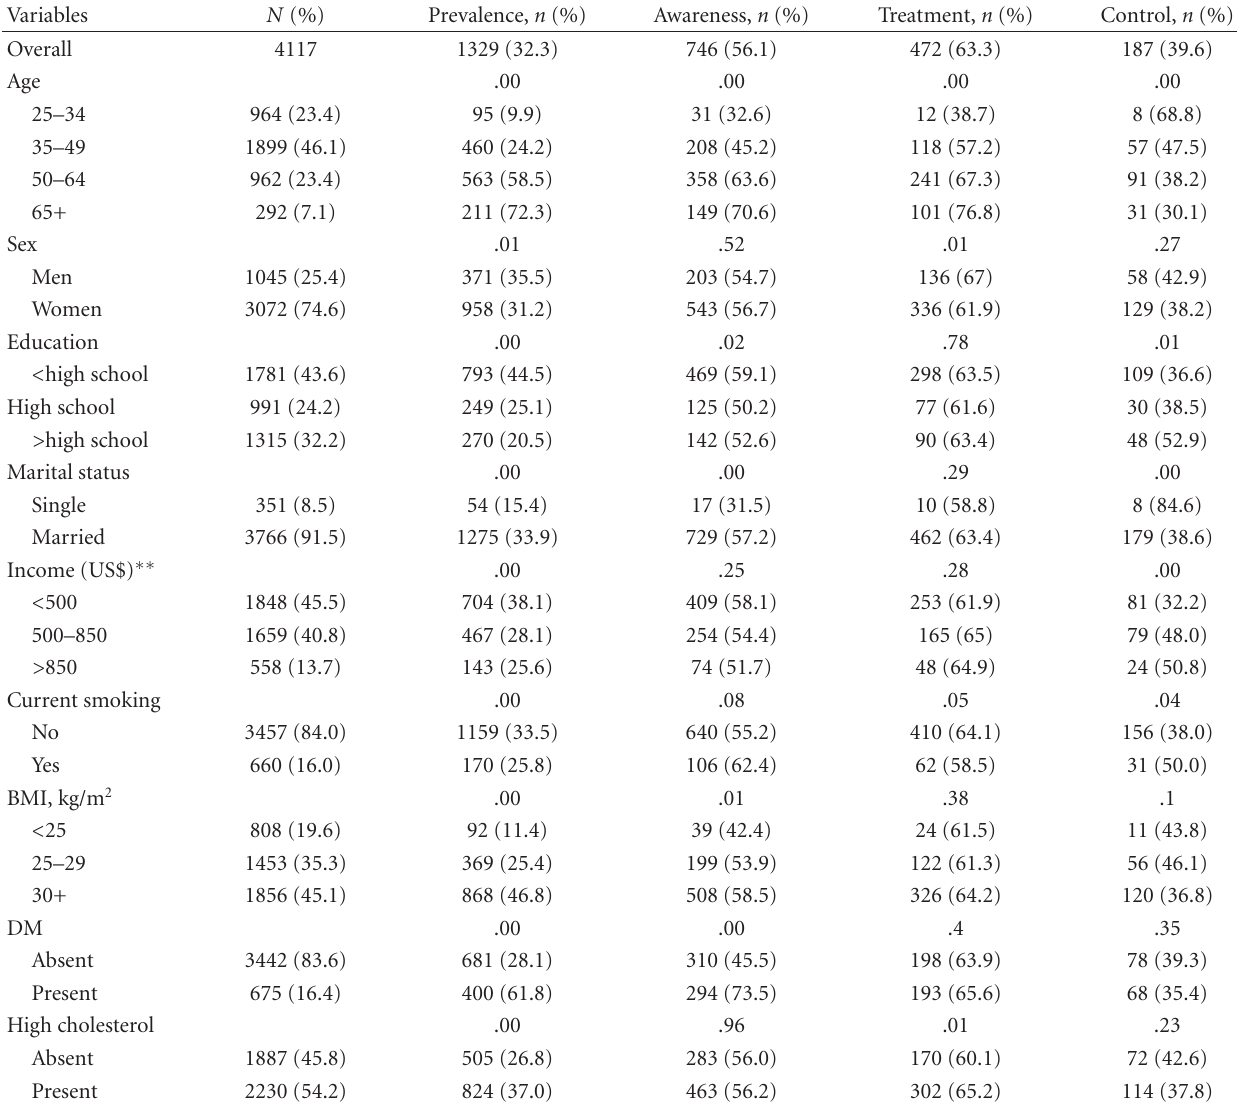
Table 1: Hypertension prevalence, awareness, treatment, and control by sociodemographic and health variables of the 2009 survey ( N = 4117) ∗